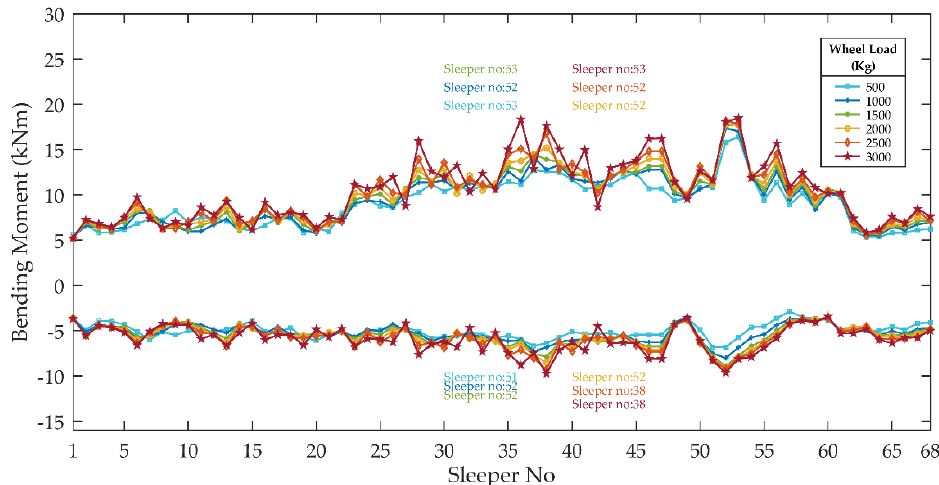
Figure 17. Longitudinal bending moment distribution with reference to different wheel loads.